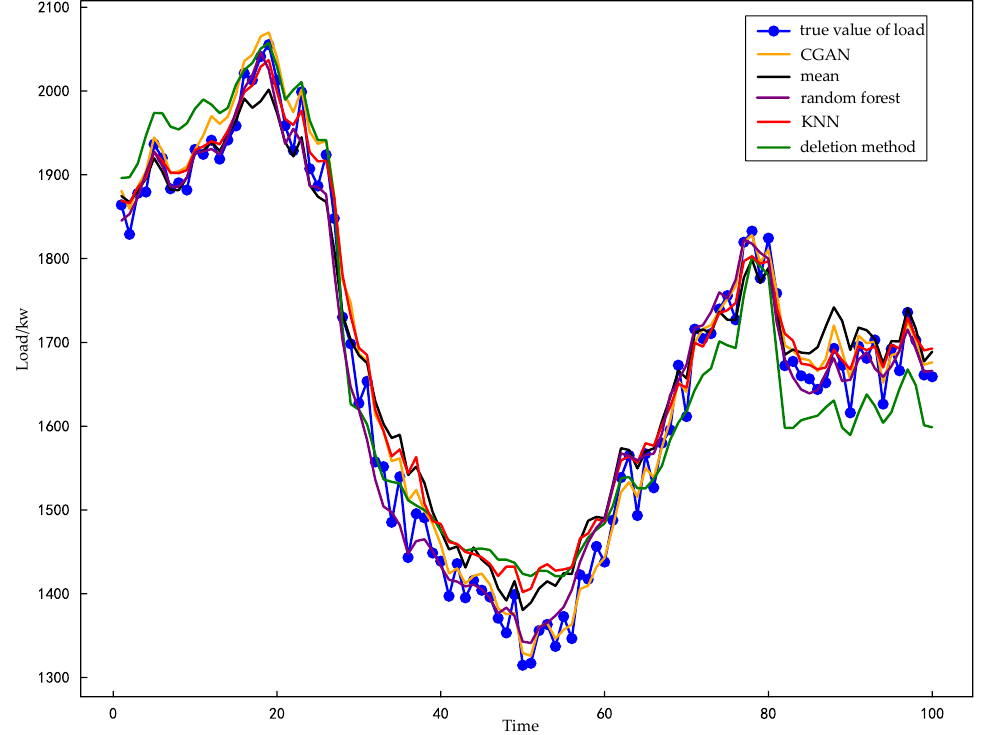
Figure 11. Prediction results under different data processing methods. Table 5. Influence of different processing methods on root mean square error of prediction.